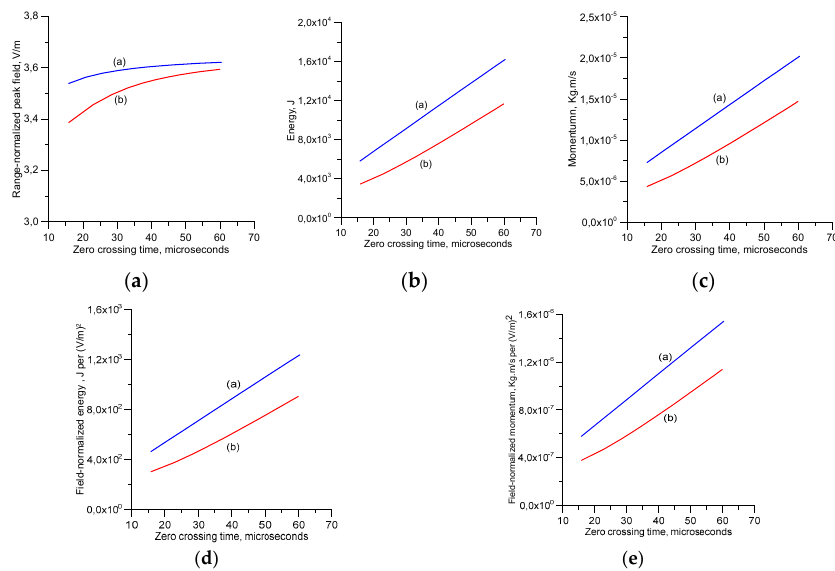
Figure 5. Results pertinent to subsequent return strokes simulated by MTLL and MTLE models with a peak return stroke current of 12 kA and a return stroke speed equal to 1.5 × 10 8 m / s. ( a ) The range-normalized (to 100 km) peak amplitude of the radiation field as a function of the zero-crossing time; ( b ) The radiated energy as a function of the zero-crossing time; ( c ) The radiated momentum as a function of the zero-crossing time; ( d ) The field-normalized energy (as defined by dividing the energy by the square of the radiation field peak at 100 km); ( e ) The field-normalized momentum (as defined by dividing the momentum by the square of the radiation field peak at 100 km). Curve (a) corresponds to the MTLL model, and curve (b) corresponds to the MTLE model. In the results presented earlier for energy and momentum, we have set the speed of propagation of the return stroke at 10 8 m/s for the first and 1.5 × 10 8 m/s for subsequent strokes. We repeated the calculations by using speeds of 2.0 × 10 8 m/s for first strokes and 2.5 × 10 8 m/s for subsequent strokes. The results obtained are shown in Figures 6 and 7, respectively, as a function of zero-crossing time. Note that even though there is a large increase in the radiated energy and momentum with increasing speeds, which indeed is caused by the increasing peak amplitude of the radiation field, the increase in the field-normalized energy and momentum is not that significant.